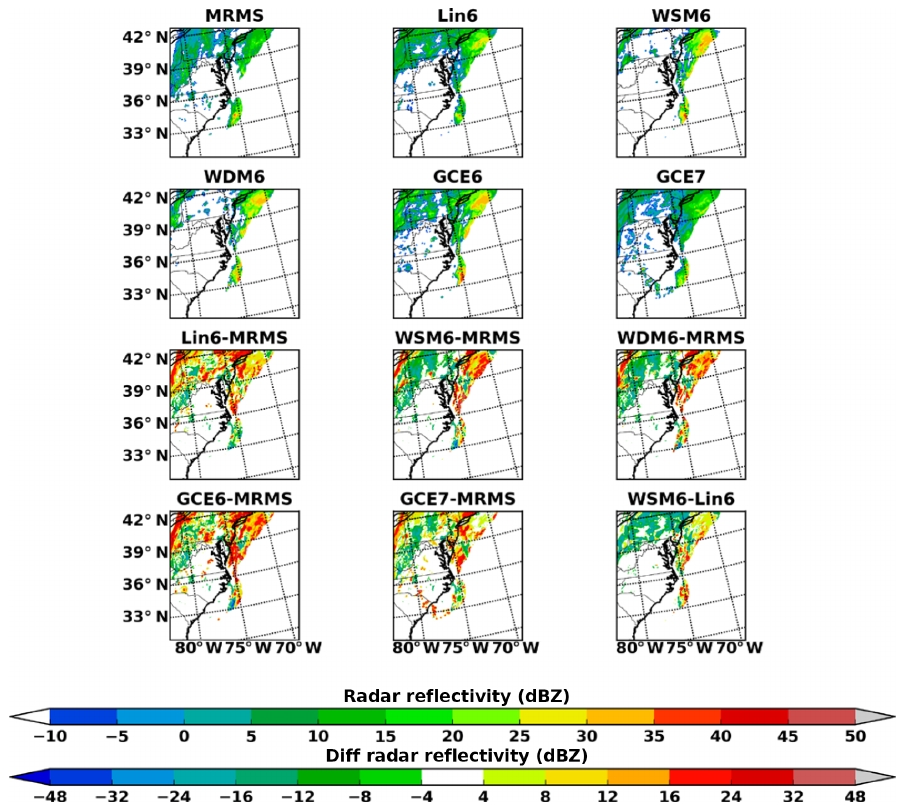
Figure 9. MRMS radar reflectivity and WRF-simulated radar reflectivity (dBZ) at 3000mabove sea level at 18:00UTC, 26 January 2015. Shown radar reflectivity differences are as